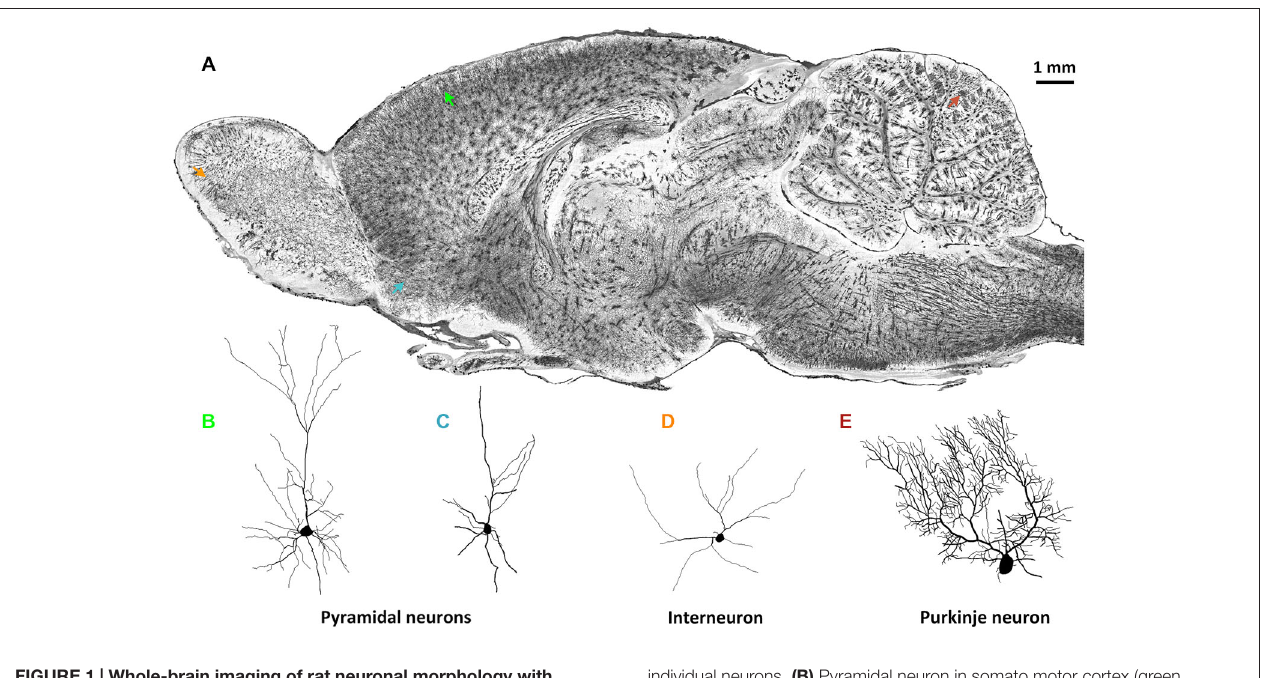
FIGURE 1 | Whole-brain imaging of rat neuronal morphology with Golgi staining (Vbn, 2015) . (A) A sagittal image of a 200 µ m thickness projection from a whole-brain imaging dataset acquired by MOST method (Li et al., 2010). Arrowheads in different colors in (A) indicate